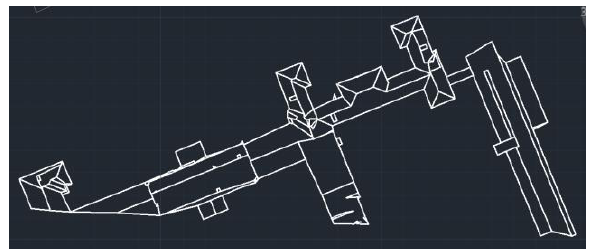
Figure 7. Roof slopes preview